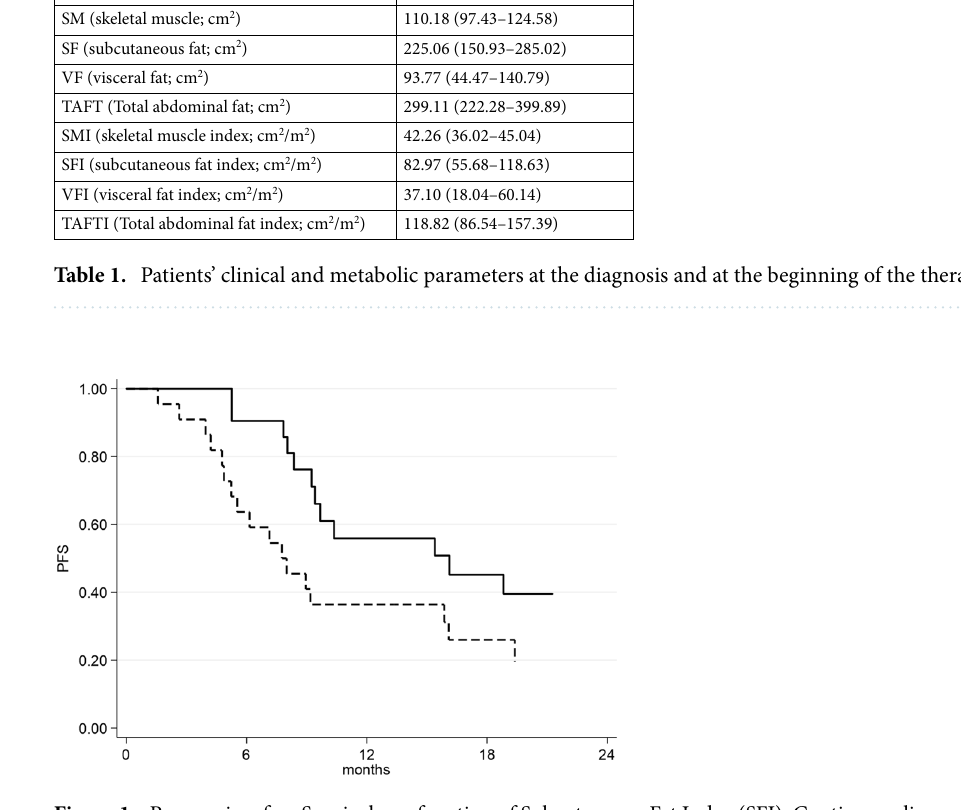
Figure 1. Progression-free Survival as a function of Subcutaneous Fat Index (SFI). Continuous line represents patients with normal (below the median value: 82.97 cm 2 /m 2 ) SFI, dashed line represents patients with high (equal or above the median value: 82.97 cm 2 /m 2 )